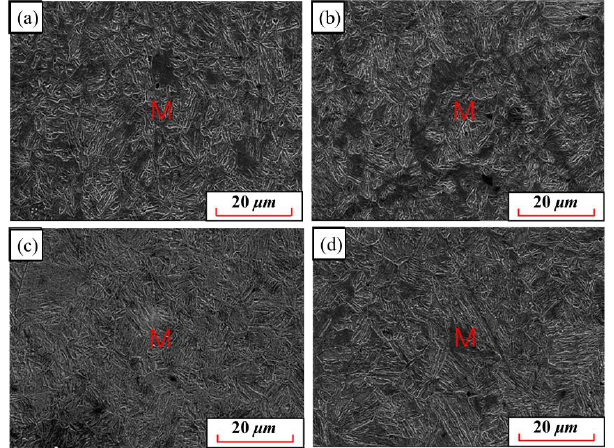
Figure 7. Microstructure of 22MnB5NbV steel after quenching at austenitizing temperature of 870 °C – 960 °C: ( a ) 870 °C; ( b ) 900 °C; ( c ) 930 °C ( d ) 960 °C.